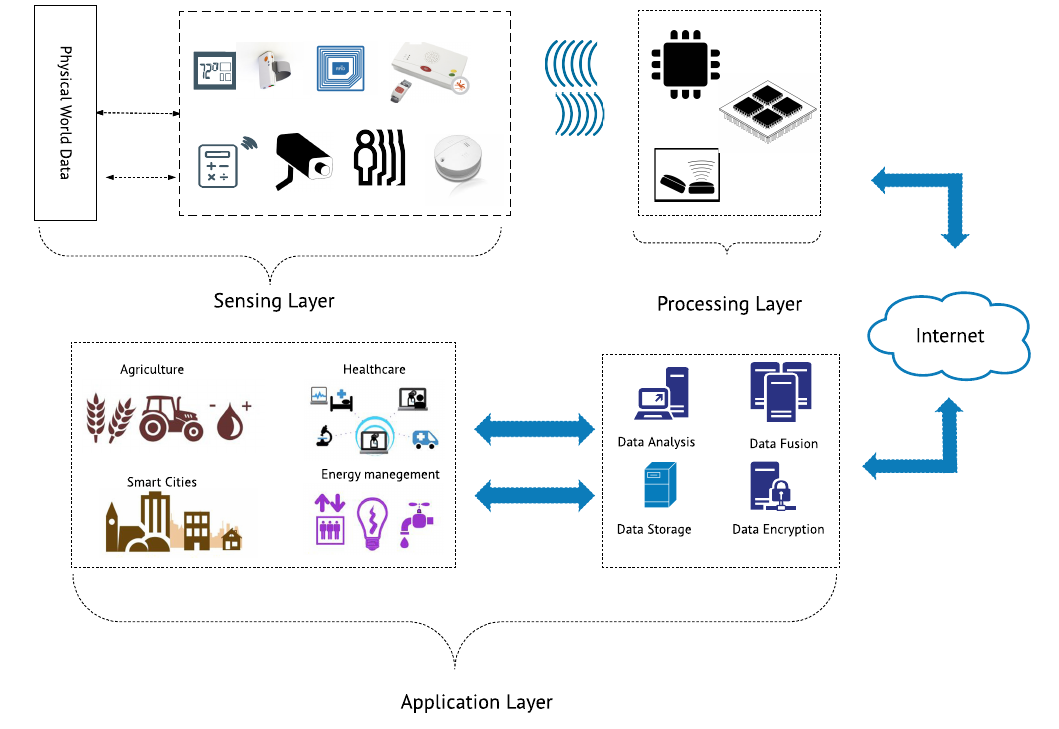
Figure 1. General IoT platform architecture considered in this paper. Table 1. A three-layer architecture for IoT